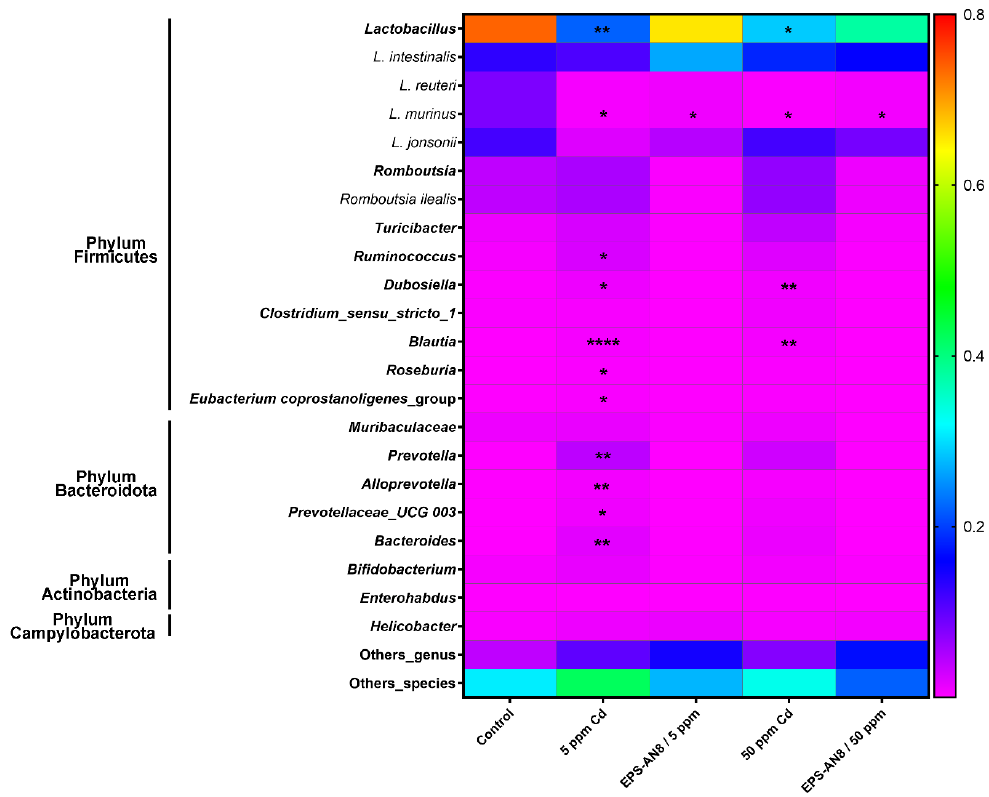
Figure 6. Relative abundance of genus and species in gut microbiota. Results are presented as median ± SD. Statistically significant differences at * p < 0.05, ** p < 0.01, and **** p < 0.0001.